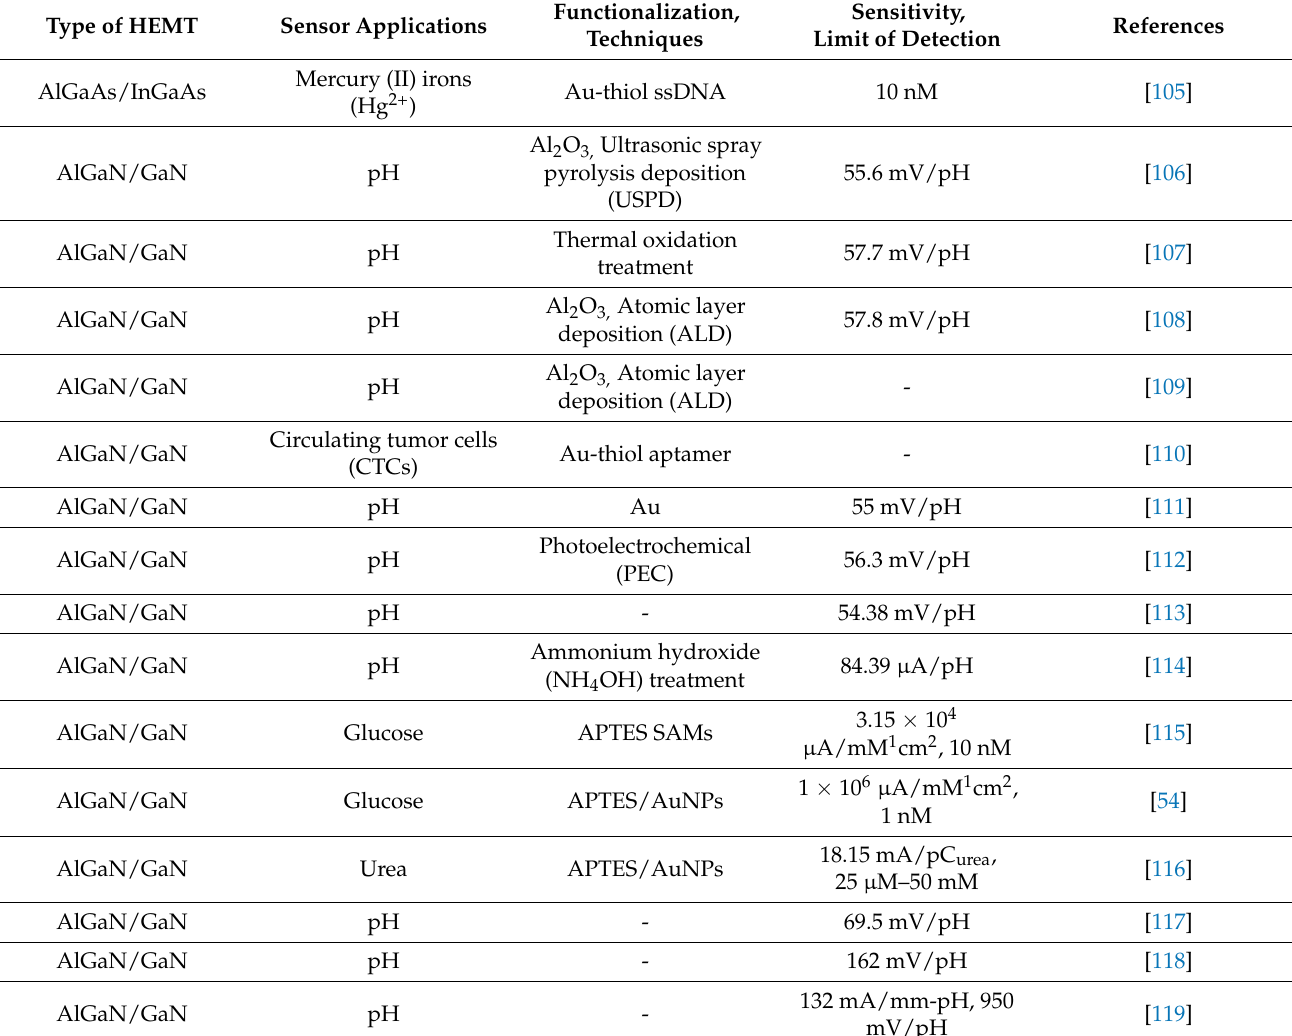
Table 3. Recent HEMT-based sensor for biosensing